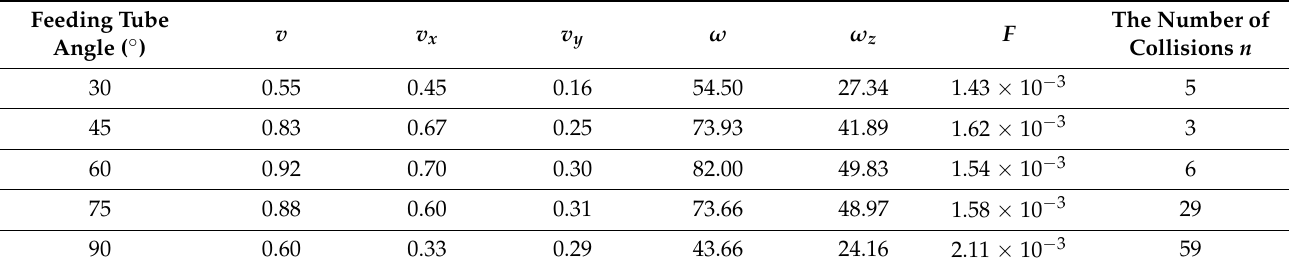
Table 2. Effect of seed insertion angle on force and speed of Table 2. E ff ect of seed insertion angle on force and speed of seeds. Feeding